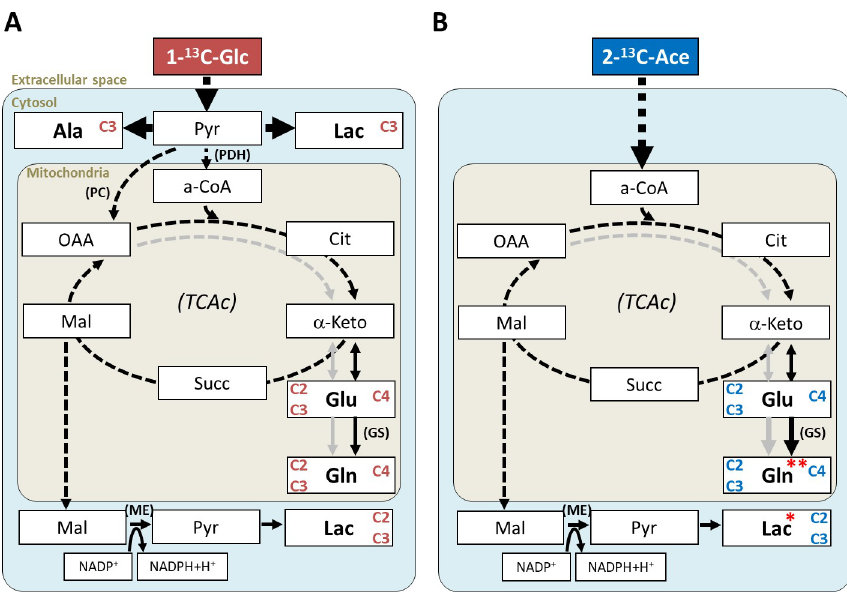
Fig 7. Models for the net cellular metabolic pathways of 13 C-isotopomer intermediates in brains and hearts for each substrate infused. Each model represents the average metabolic pathways for the intermediates displayed, not accounting for intra-tissue heterogeneities (e.g. neurons vs. glia metabolic compartments), and according to infusions of: 1- 13 C-Glc (A) and 2- 13 C-Ace (B) . Labelled metabolite detectable in FGR and AGA fetal brain and heart samples are indicated with “Cn” (n = carbon position(s) for the labelling), and grey arrows indicate the second turn of the TCAc. Significant changes in FGR subjects: � brain, lower Lac C2C3 levels; �� heart, lower Gln C4 (and tendency for lower relative activity of GS). Other abbreviations: Cit, citrate; a-CoA, acetyl-coenzyme A; α -Keto, alpha-ketoglutarate; Succ, succinate; Mal, malate; OAA, oxaloacetate; Pyr, pyruvate; PDH, pyruvate dehydrogenase; PC, pyruvate carboxylase; ME, malic enzyme; GS, glutamine